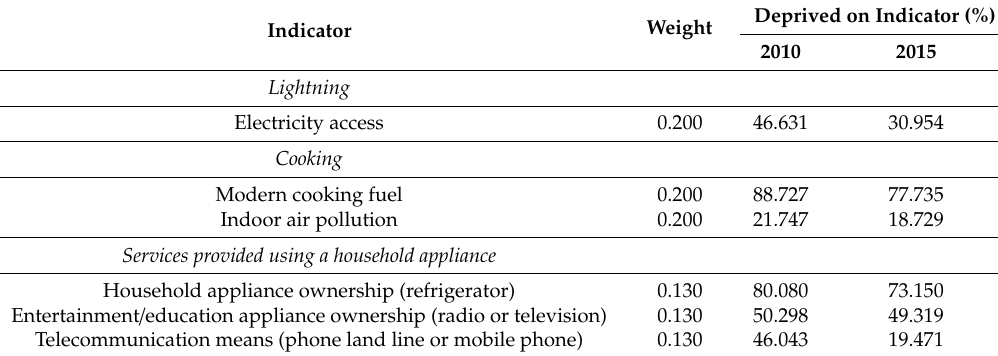
Table 2. Summary of deprivation indicators by energy services between 2010 and